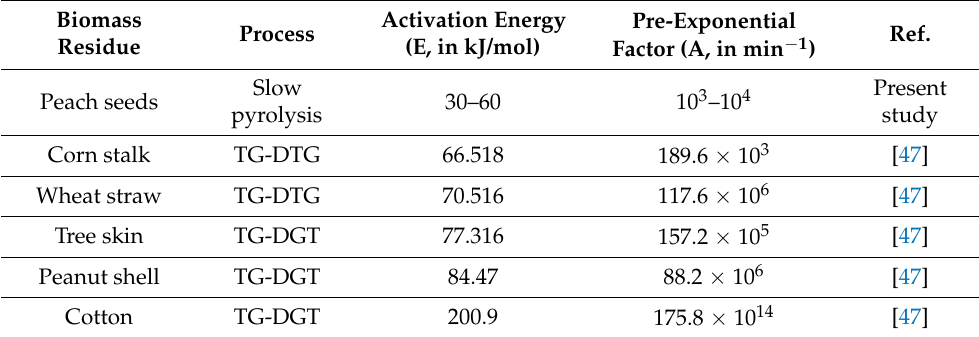
Table 7. Comparison of peach seeds pyrolysis kinetic parameters with those of different biomass feedstocks reported in the